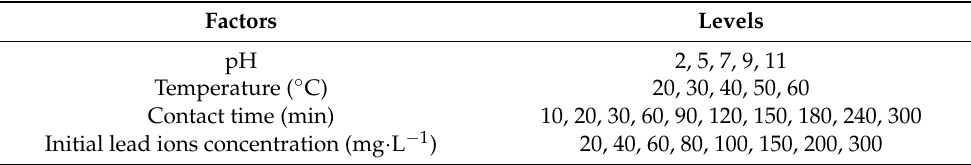
Table 2. List of the factors and their levels for single factor analysis. Factors Levels